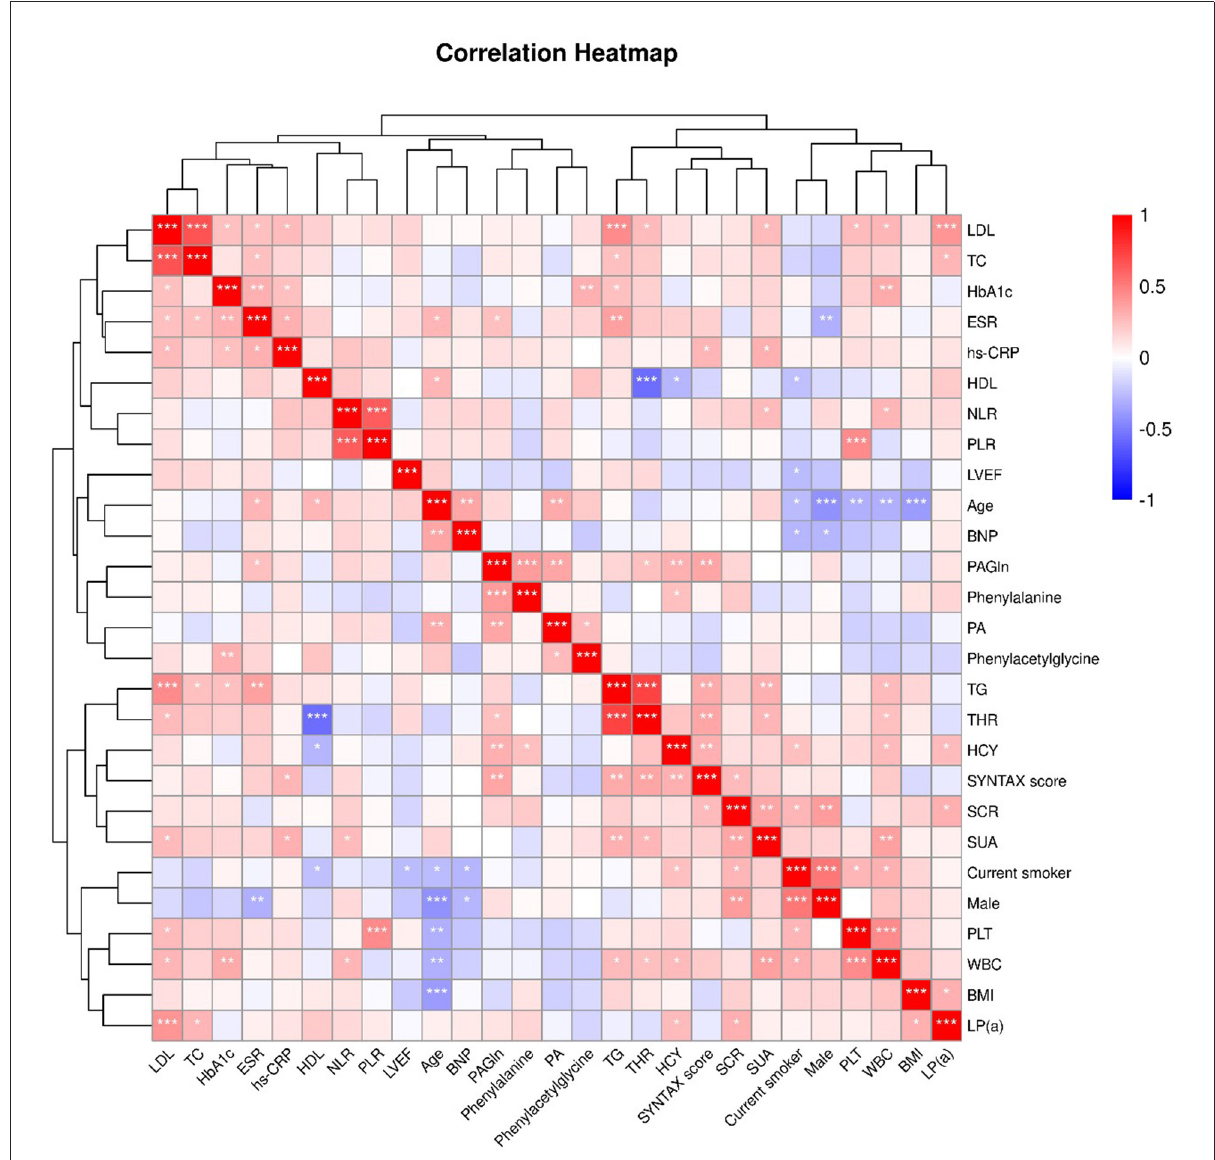
FIGURE2 Heatmap showing the correlation between clinical characteristics. The correlation coefficient (Spearman’s correlation analysis) is expressed in different colors, Red, positive correlation, Blue, negative correlation. *, P < 0.05; **, P < 0.01; ***, P < 0.001. LDL, low-density lipoprotein cholesterol; TC, total cholesterol; HbA1c, glycosylated hemoglobin, type A1C; ESR, erythrocyte sedimentation rate; hs-CRP, high-sensitivity C-reactive protein; HDL, high- density lipoprotein cholesterol; NLR, neutrophil-lymphocyte ratio; PLR, platelet- lymphocyte ratio; LVEF, Left ventricular ejection fraction; BNP, B-type natriuretic peptide;PAGln, phenylacetylglutamine; PA, phenylacetic acid; TG, triglyceride; THR, TG-HDL ratio; HCY, homocysteine; SCR, serum creatinine; SUA, serum uric acid; PLT, platelet; WBC, white blood cell; BMI, body mass Index; LP(a),